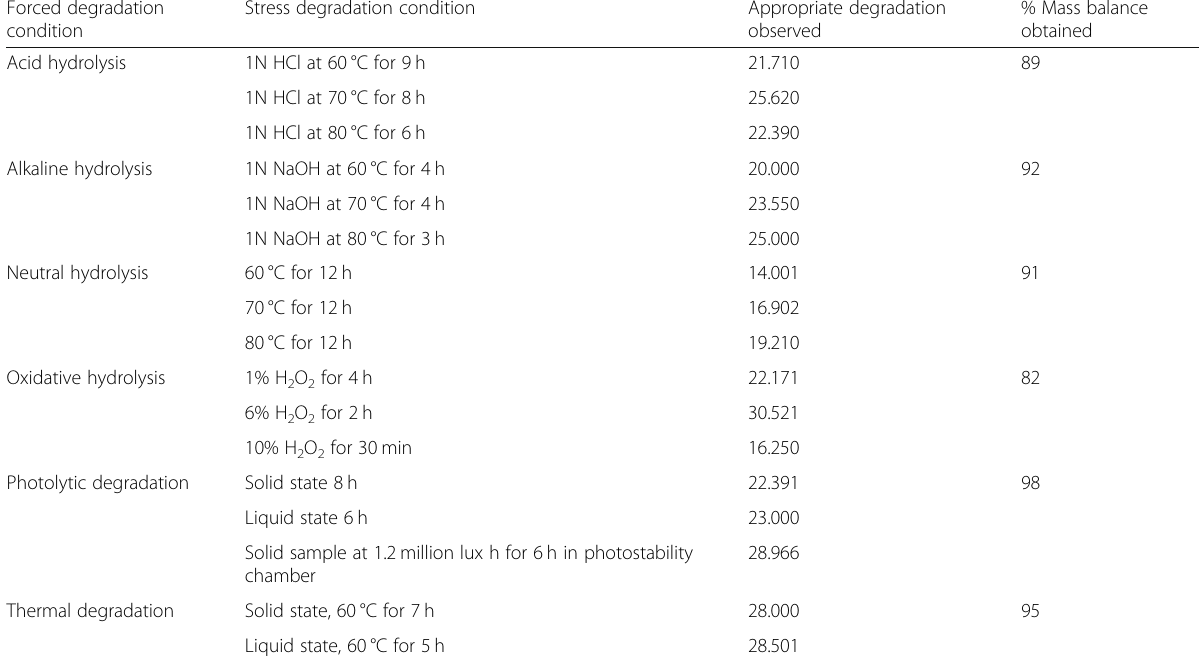
Table 4 Result from stress degradation study of AV Forced degradation Stress degradation condition Appropriate degradation condition